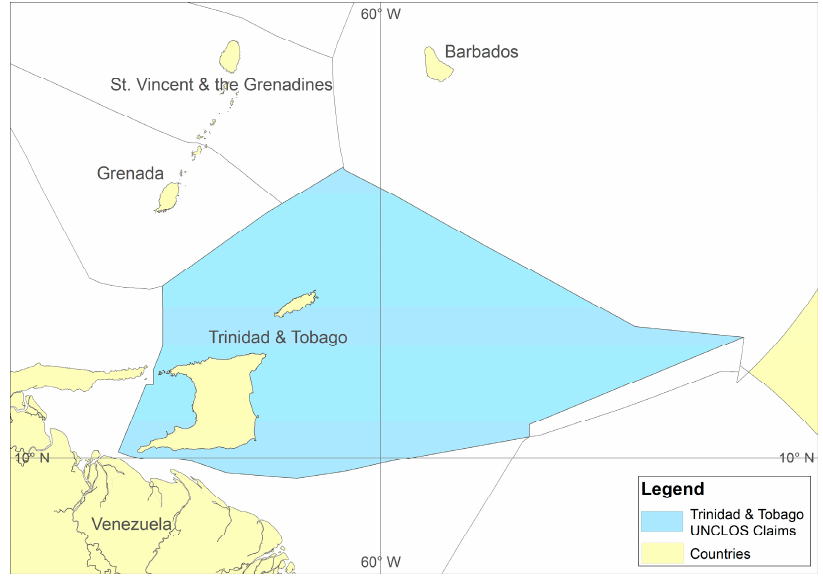
Figure 12. Trinidad and Tobago UNCLOS claim.